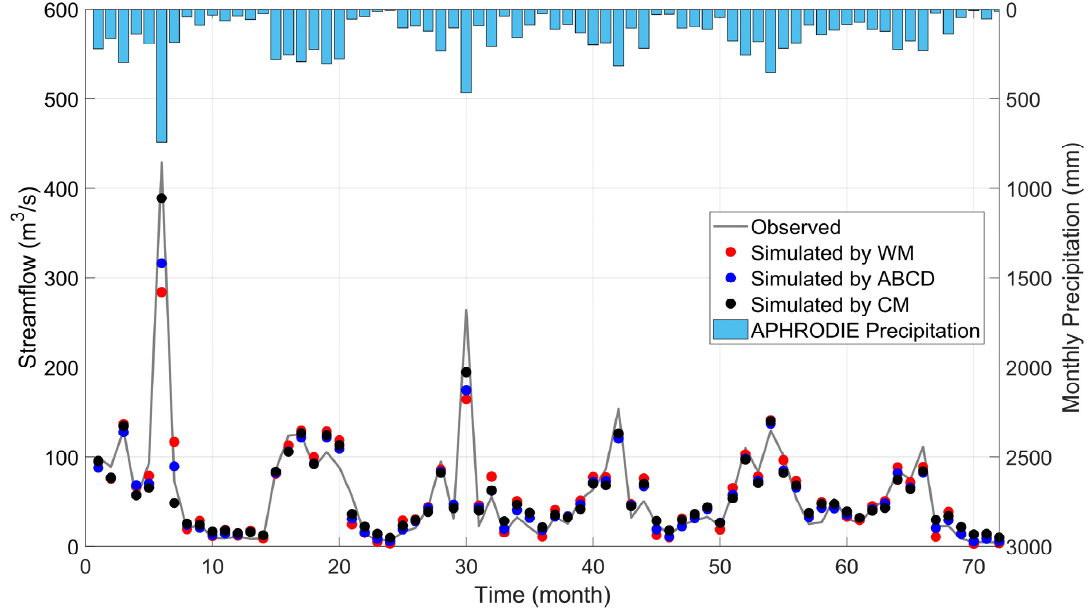
Figure 7. Comparison of simulated and measured monthly runoff at LQ Station.